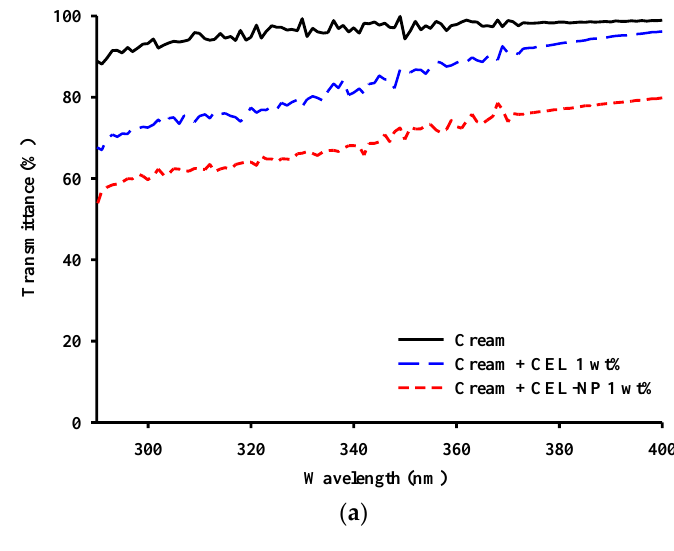
( a ) Figure 5. Cont